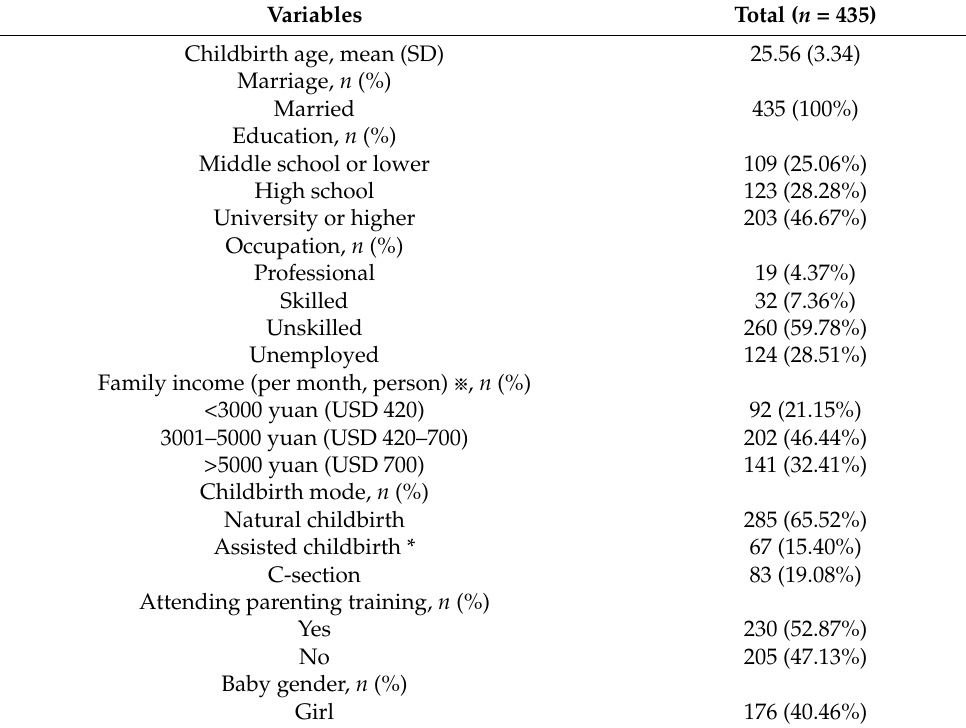
Table 2. The social–demographic and clinical characteristics of participants ( n =